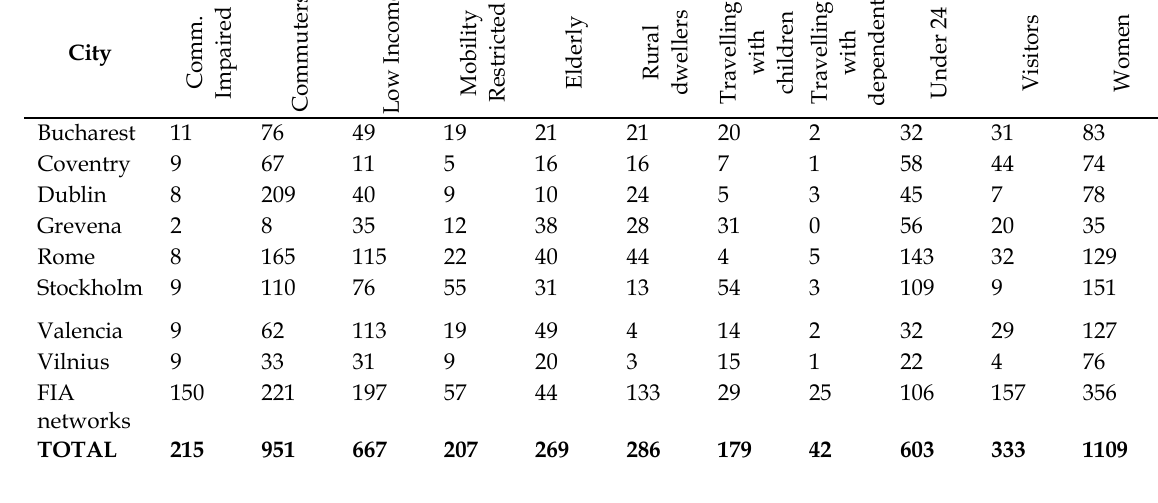
Table 3. Distribution of valid respondents by travel mode 15